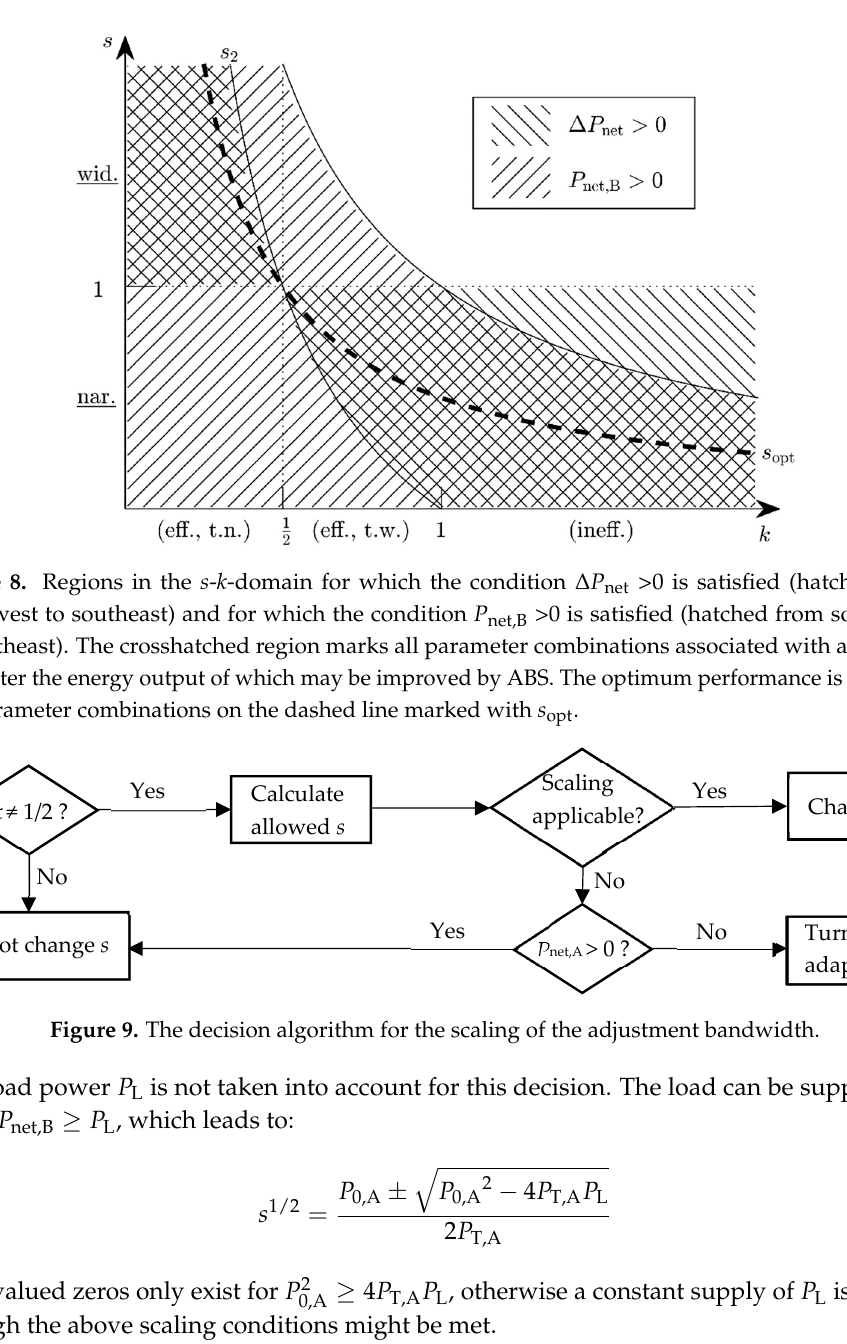
Figure 7. P net,B after ABS with a factor of s with the power ratio k (=adjustment power divided by power harvested prior to the ABS) as a parameter.